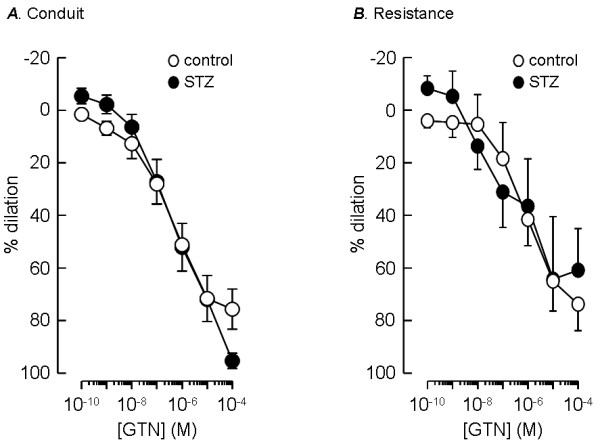
Resistance of endothelium-independent vasodilation to STZ-induced diabetes. Dilator responses to increasing concentrations of glyceryl trinitrate (GTN), measured as a percentage of pre-constrictor tone, in conduit (A) and resistance-sized (B) intrapulmonary arteries from STZ-treated (solid circles) and age-matched control (open circles) rats. Data plotted are mean ± s.e.m. of 8–9 animals.